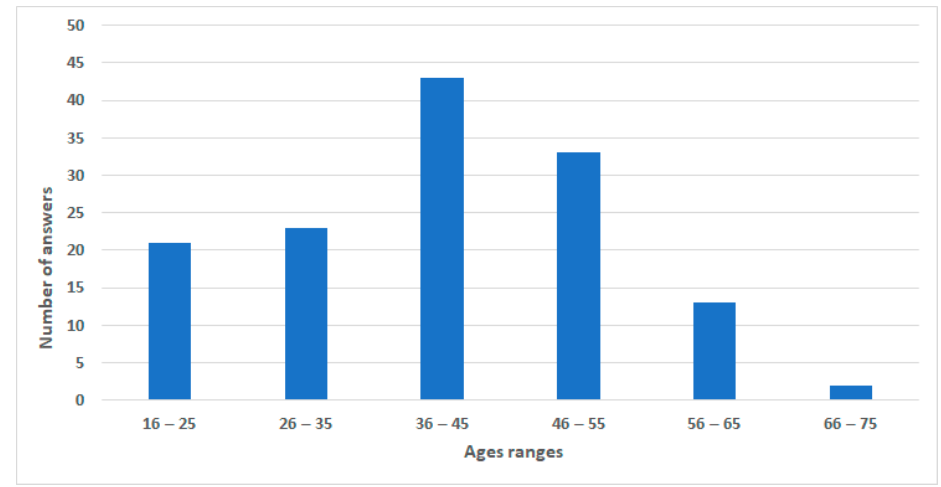
Figure 2. Age range of survey respondents.